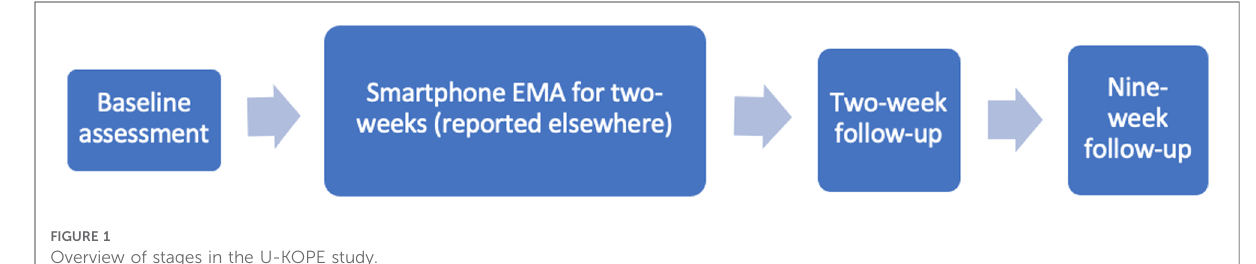
FIGURE 1 Overview of stages in the U-KOPE study.